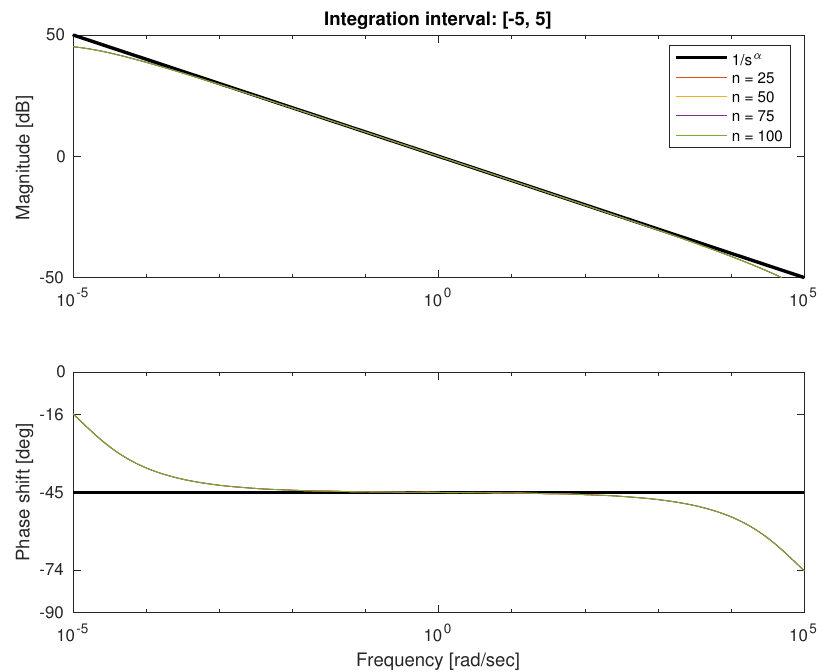
Figure 10. Analysis of frequency responses approximations with Clenshaw–Curtis quadrature and the integration interval of [ − 5,5 ] .